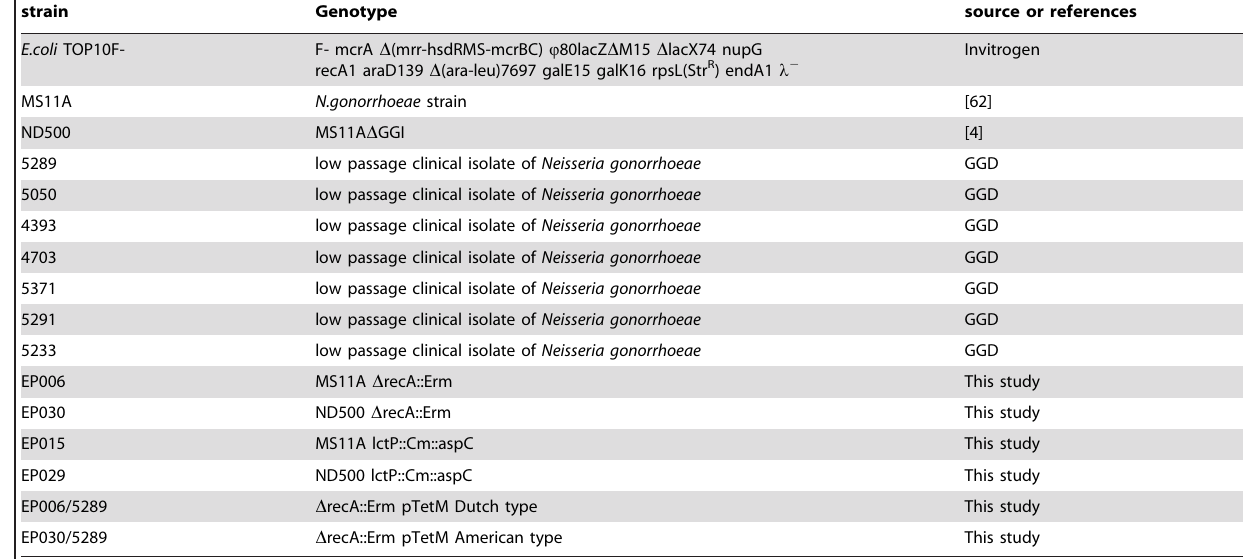
Table 3. Strains used in this